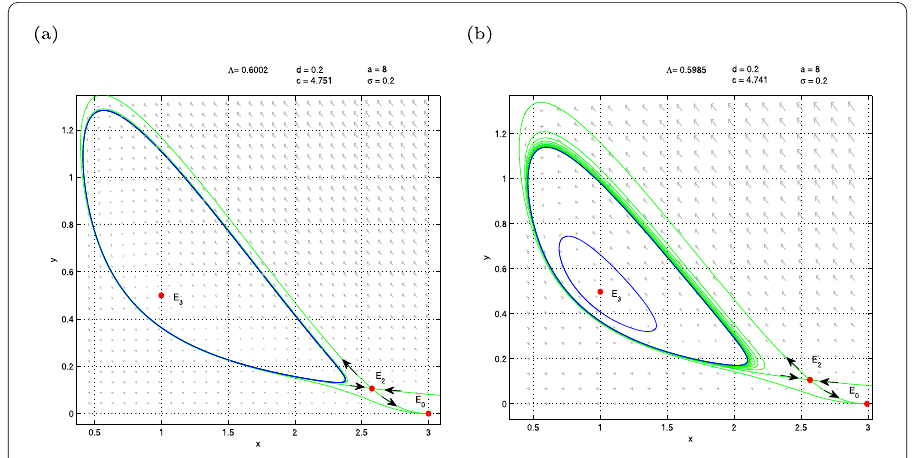
3 , and the small one is stable, the large one is unstable